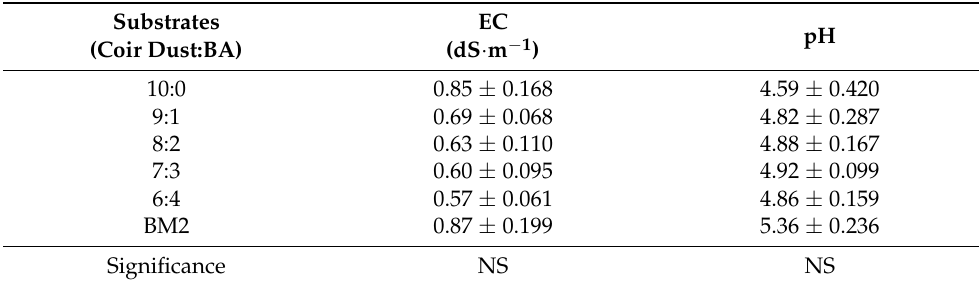
Table 2. Electric conductivity and pH in substrates mixed with coir dust and coal bottom ash (BA) and commercial germinating mixture BM2.